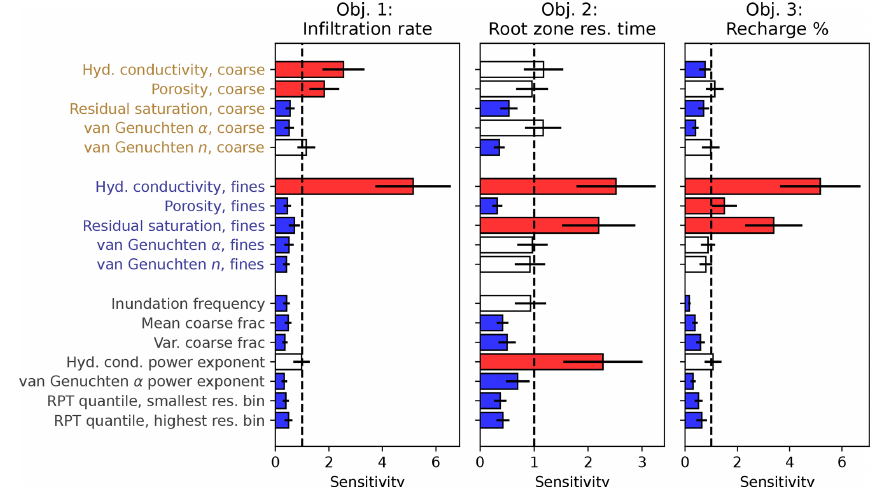
Figure 9. Results of distance-based generalized sensitivity analysis (DGSA) for three outcomes of interest. Parameters are grouped according to whether they describe coarse facies (yellow labels), describe fine facies (blue labels) or are universal (black labels). Bars are colored according to whether a parameter is influential (red, sensitivity metric > 1), insignificant (blue, sensitivity metric < 1) or in between (white, sensitivity metric confidence interval includes 1). The principal component scores on coarse fraction for each simulation were included as additional parameters in DGSA but are not shown here as none are